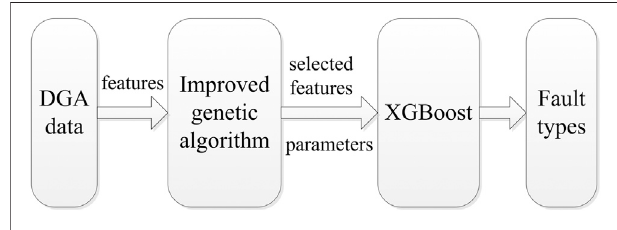
FIGURE 3 | Structure of the IGA-XGBoost. The IGA is used for the combined optimization of the input features and the XGBoost parameters, and the trained XGBoost is used to identify the fault types.